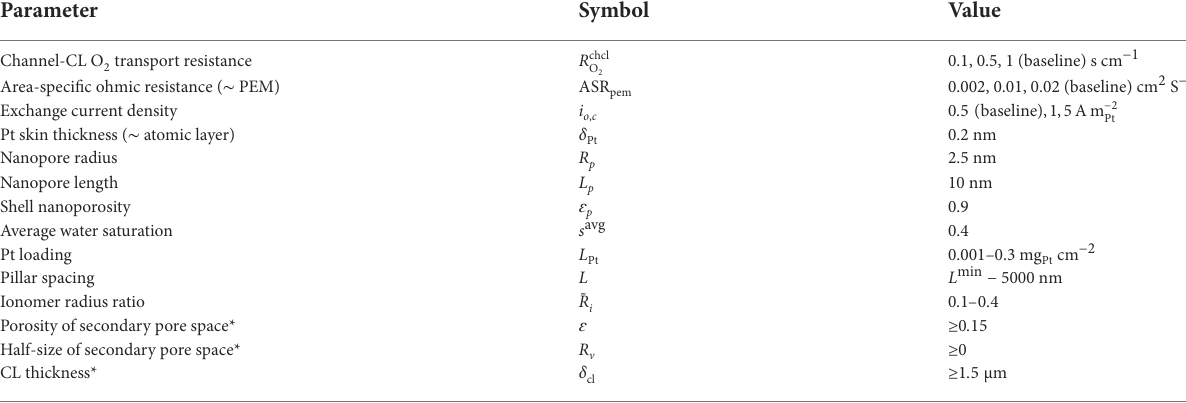
TABLE 1 Modelparameters.Thebaselinecasecorrespondsto R chcl indicatedwithanasteriskandtheoperatingconditionsareincludedinthefootnote.